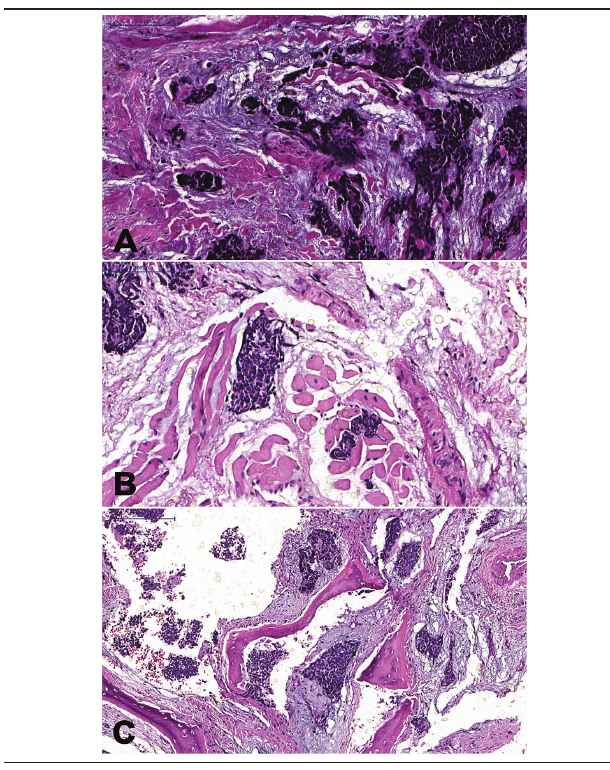
figura 2 − Microscopia A) invasão perineural; B) invasão muscular; C) invasão óssea de ninhos e ilhas de células tumorais (100 μm, HE). HE: hematoxilina e